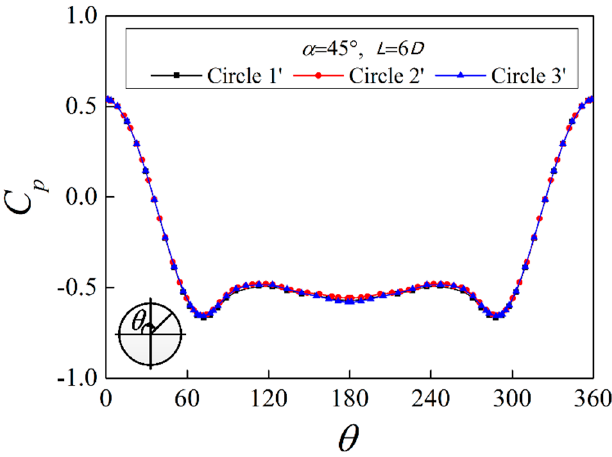
Figure 12. Pressure profiles under periodic boundary condition on the two end-plate walls at α = 45°.